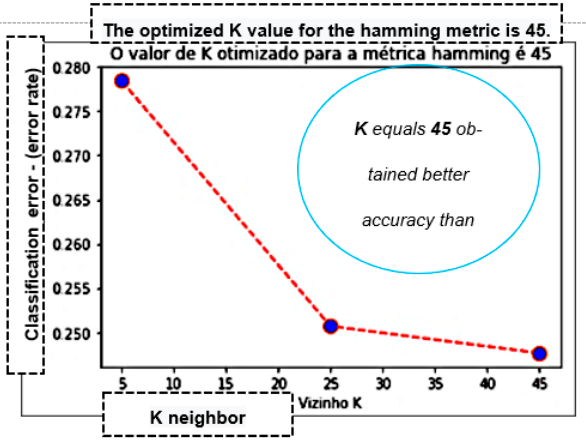
Figure 4. K optimized. Figure 4. K